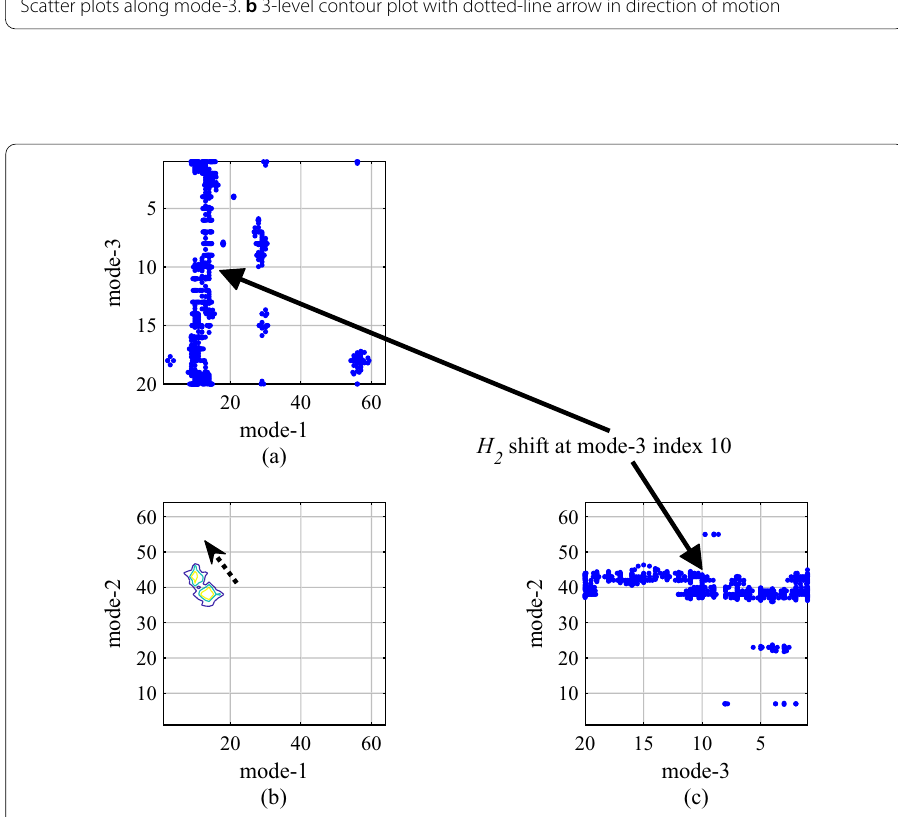
Fig. 10 Phase congruency in computed tensor M with apparent motion of H 2 at frame 10 (mode-3 index 10). a , c Scatter plots along mode-3. b 3-level contour plot with dotted-line arrow in direction of